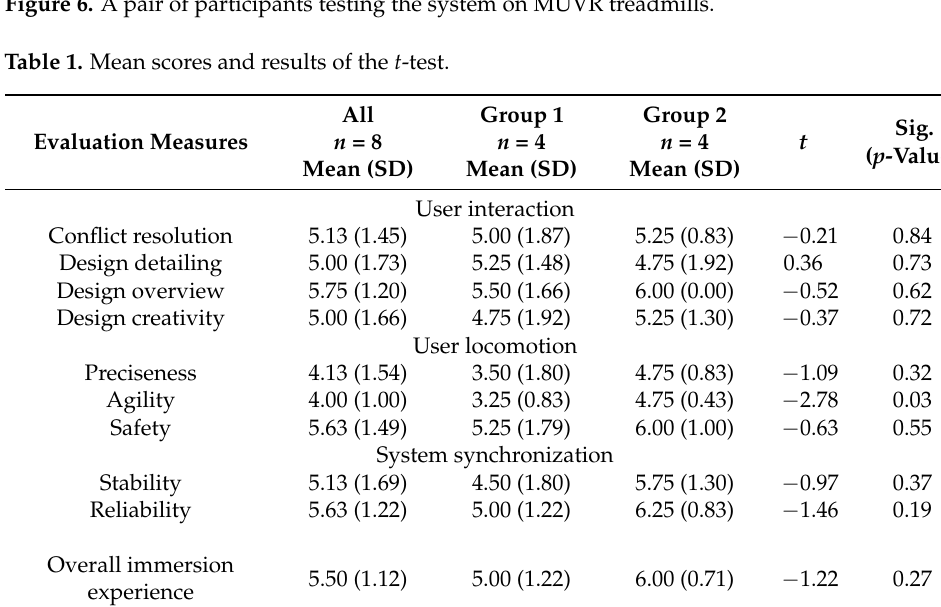
Table 1. Mean scores and results of the t -test.